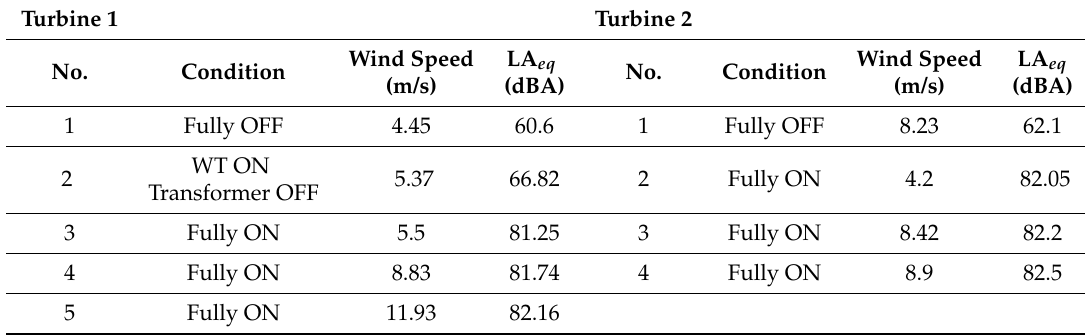
Table 1. Acoustic measurements: Turbine 1: sound drive-train, Turbine 2: with bearing